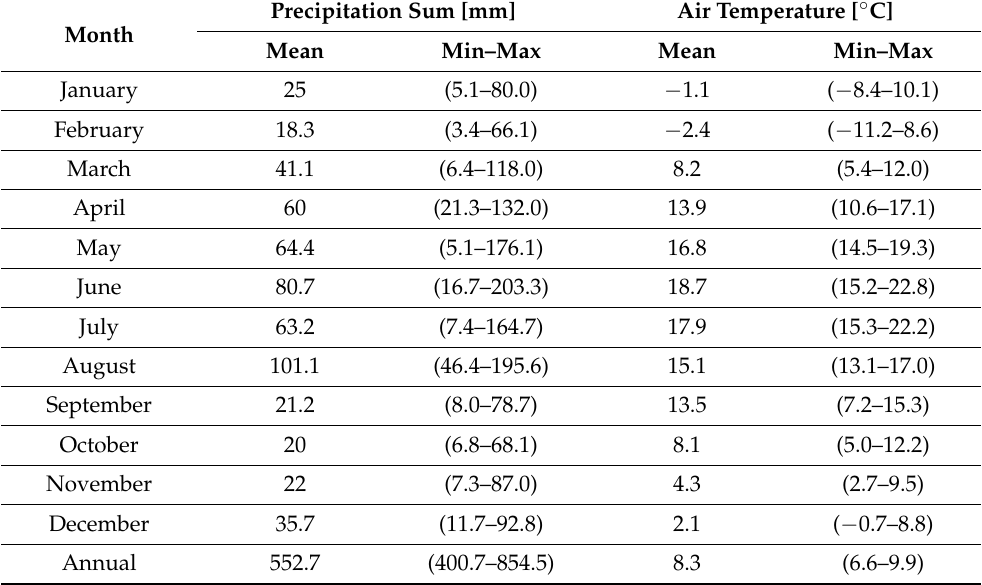
Table A2. Monthly and annual precipitation and temperature values across 1966–2015 in Warsaw University of Live Science Experimental Station in Skierniewice, shown as mean